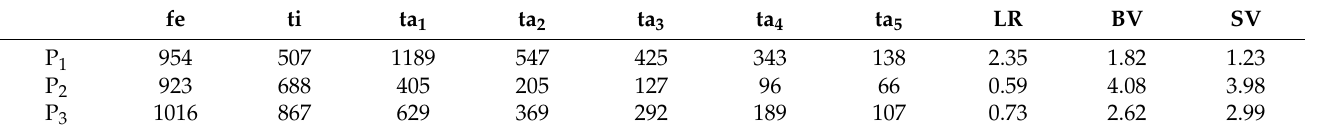
Table 4. Lengths (in µ m) and proportions of legs of Rheotanytarsus illiesi Siebert 1979, adult male ( n = 1).